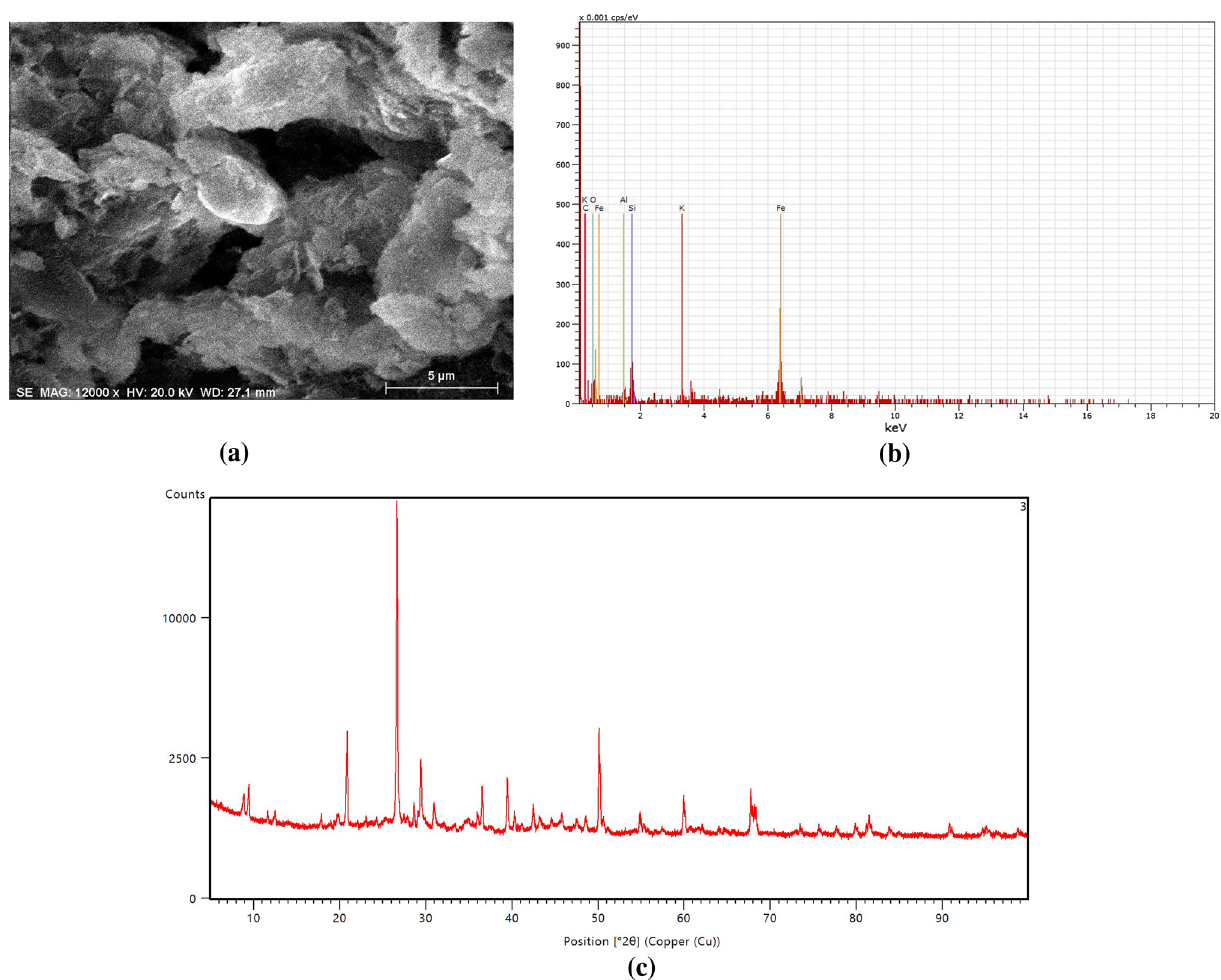
Fig. 7 SEM, EDS and XRD analyses of 60th day compost (Mandi